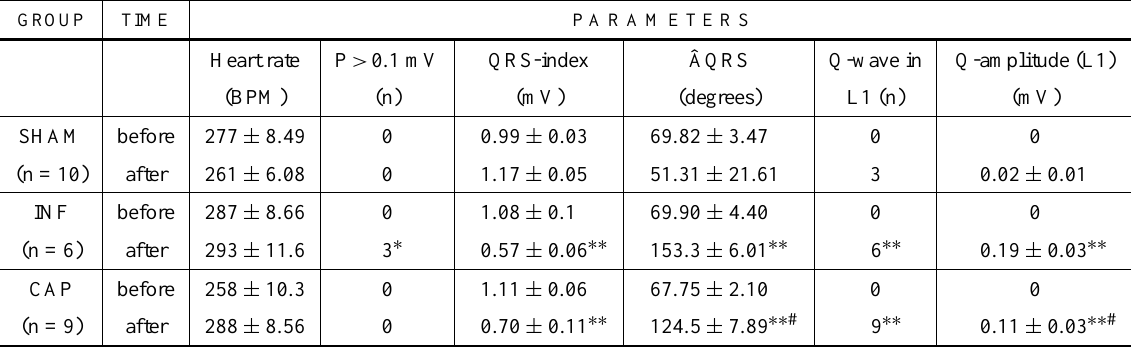
Electrocardiographic parameters recorded from SHAM, INF and CAP just before and 21 days after surgery. Data are means ± SEM. n = number of rats, I-QRS = QRS amplitude index, ÂQRS = frontal QRS